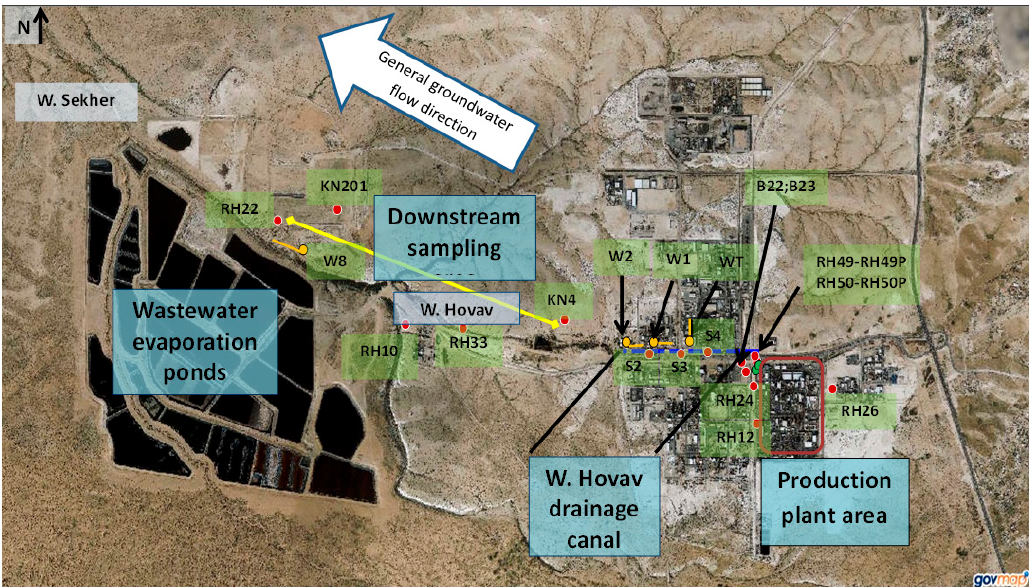
Figure 1. Boreholes sampled in the Neot Hovav industrial site: Adjacent to the production plant; Along the Hovav drainage canal; and downstream to the production plant. Red circles—monitoring boreholes; orange circles-boreholes along drainage canal. Govmap https://www.govmap.gov.il/2016.